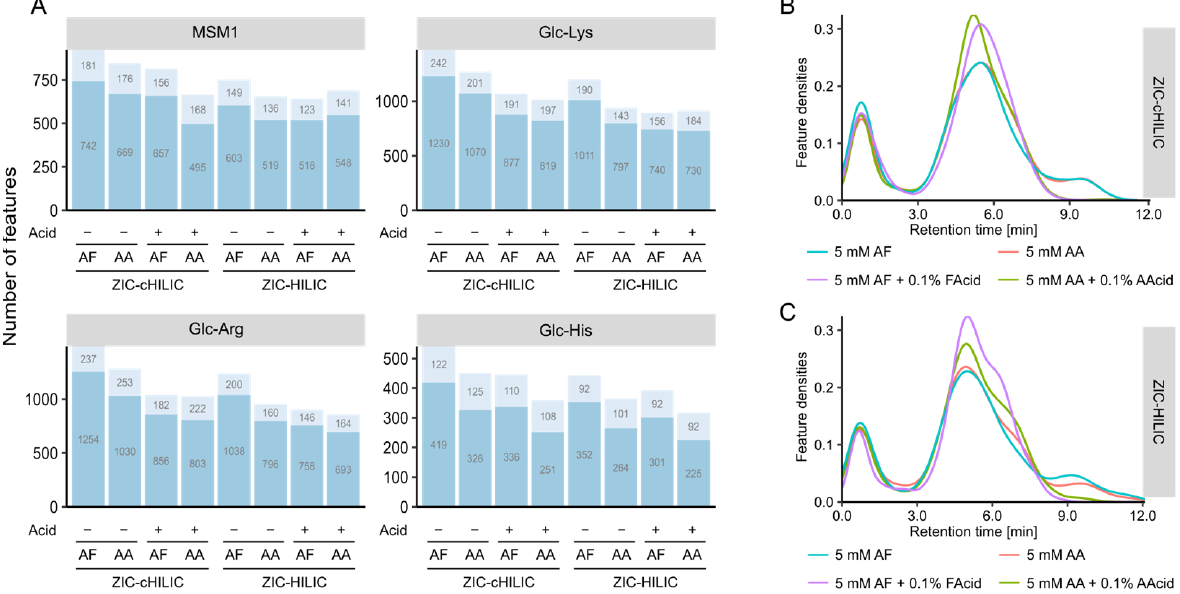
Figure 4. Effects of mobile phase composition on feature coverage and distribution. ( A ) Bar plots representing the number of detected features analyzed by mobile phases consisted of 5 mM ammonium formate (AF) or 5 mM ammonium acetate (AA) with and without its corresponding acid (0.1%, v / v ). ( B ) Density distribution of retention times across the chromatographic run for ZIC-cHILIC column and ( C ) ZIC ‐ HILIC column.